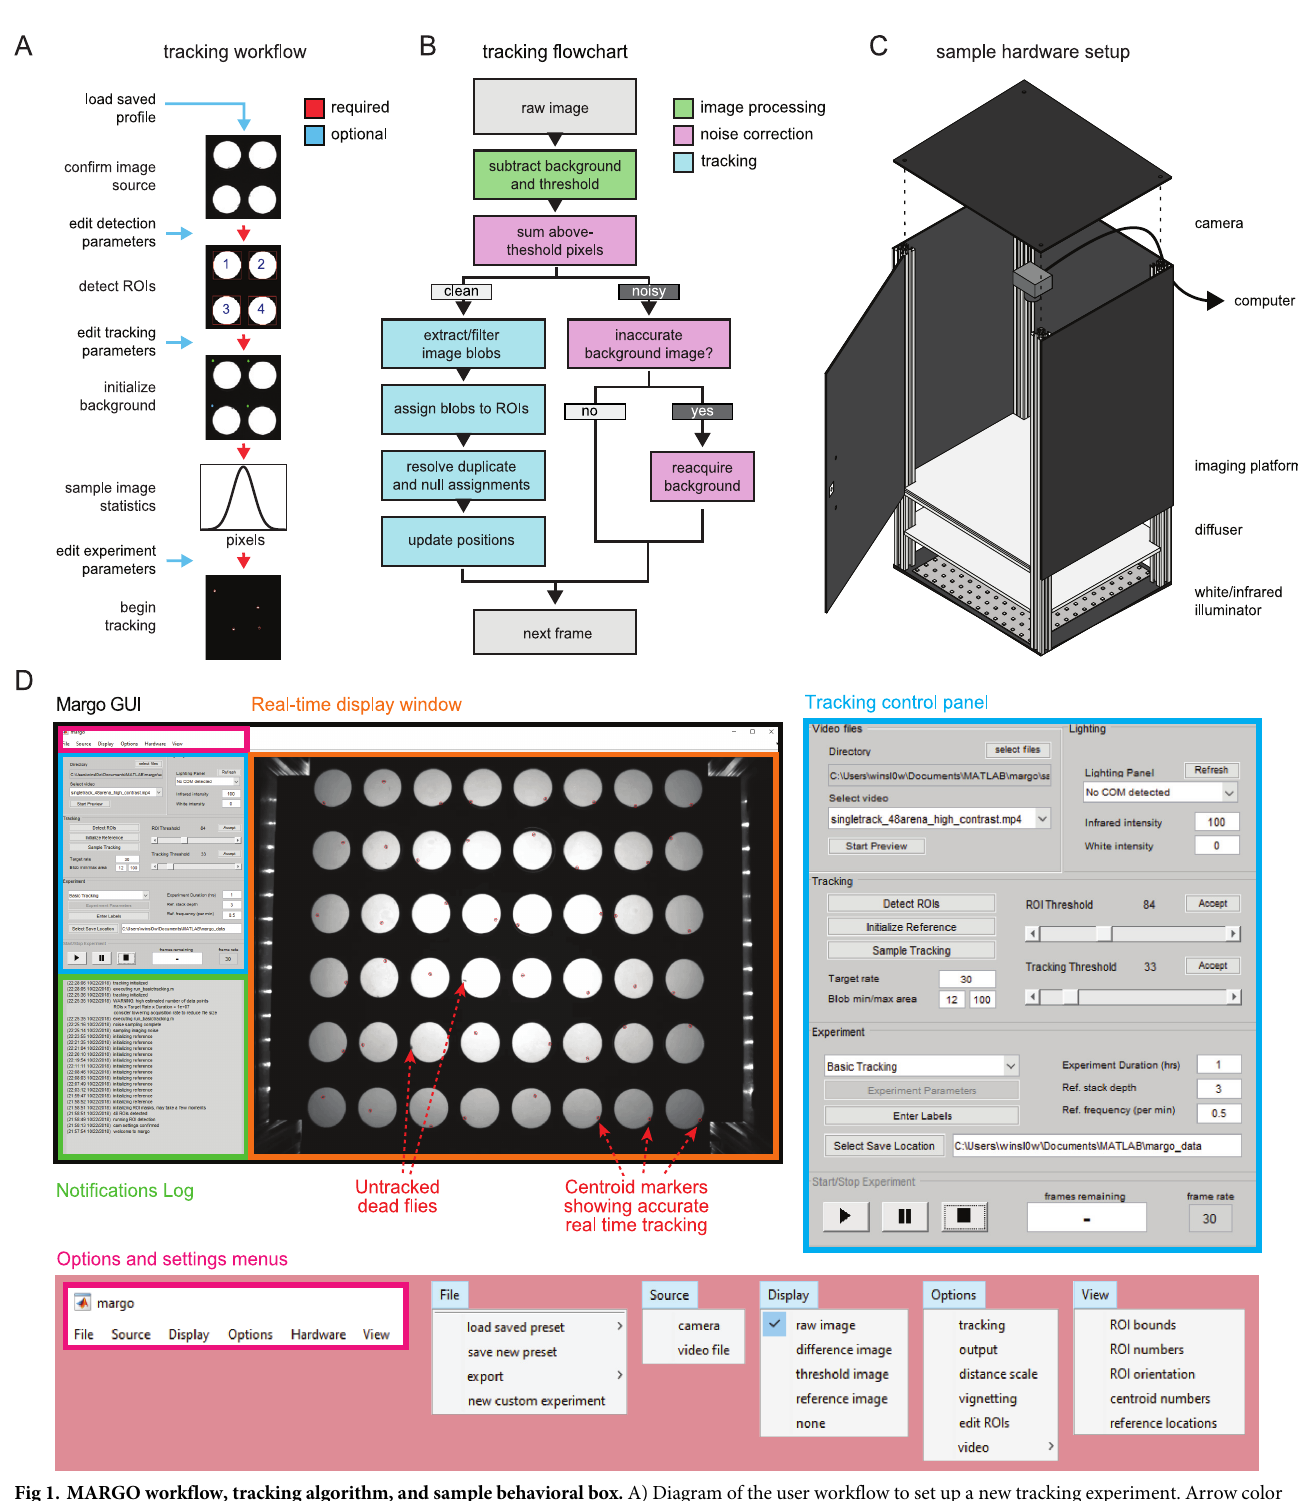
Fig 1. MARGO workflow, tracking algorithm, and sample behavioral box. A) Diagram of the user workflow to set up a new tracking experiment. Arrow color indicates whether the setup step is required. Before tracking, users define an input source, define ROIs to track, initialize a background image used to separate foreground and background, and sample the image statistics on a reference of clean tracking. Tracking parameters can be customized at multiple points (blue arrows). B) Flowchart depicting the MARGO’s frame-to-frame tracking routine. Each frame consists of image processing (green) to segment foreground from the background, noise estimation (magenta) to assess the quality of foreground segmentation and determine if the current frame can be tracked, and tracking (cyan) of